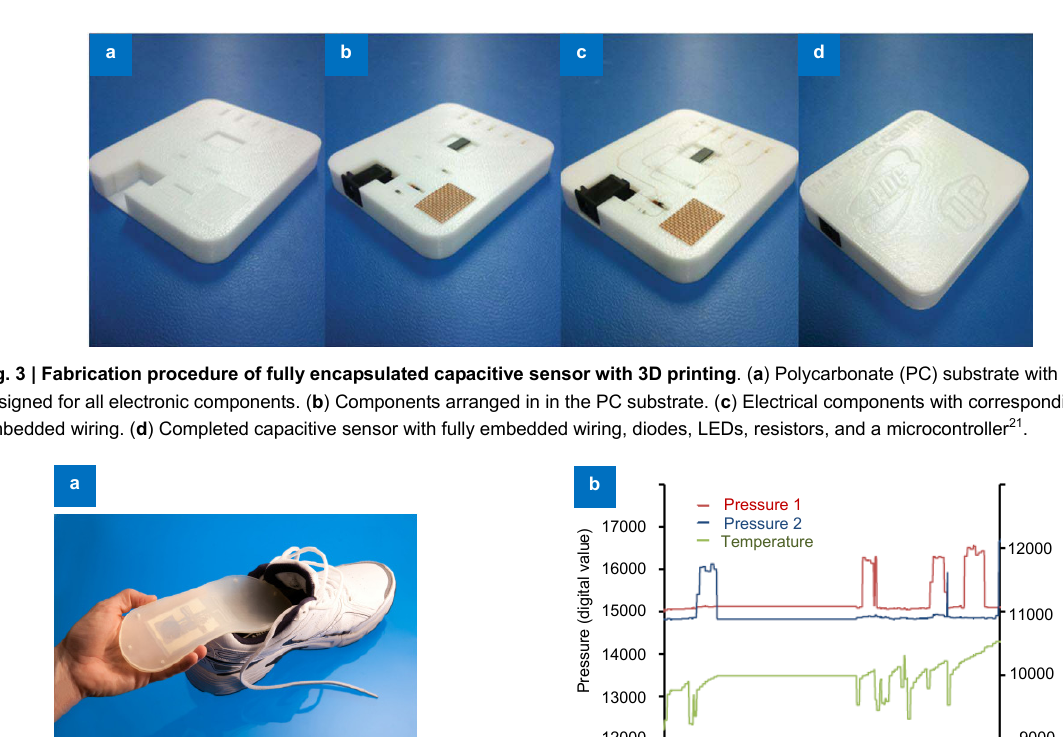
Fig. 2 | ( a ) Process flow of the multi 3D system. ( b ) Fabricated parts 9,14 .